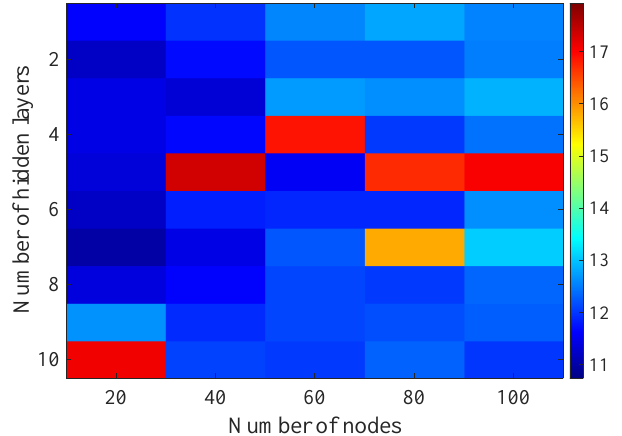
Figure 13. Matrix of the BLER RMSE metric predictions for the instantaneous values of the radio parameters in the second stage learning process.